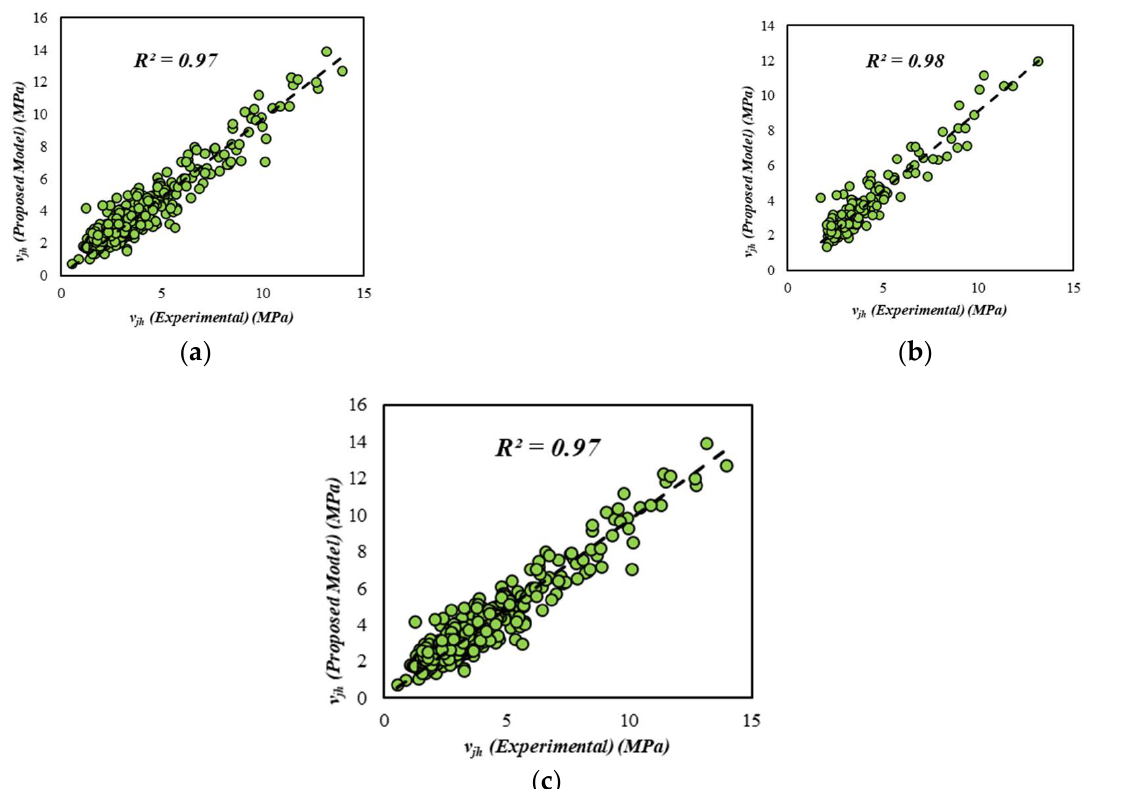
Figure 5. Comparison of estimated and experimental shear strength: ( a ) Training data, ( b ) Validation data, ( c ) All data.